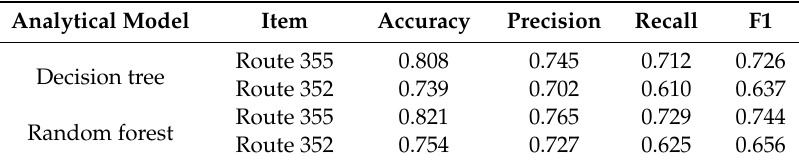
Figure 11. Feature weights of different schemes in the case study. Table 10. Classification indicators of each model in the case study. Table 13. Classification rules of route 352 in the case study.